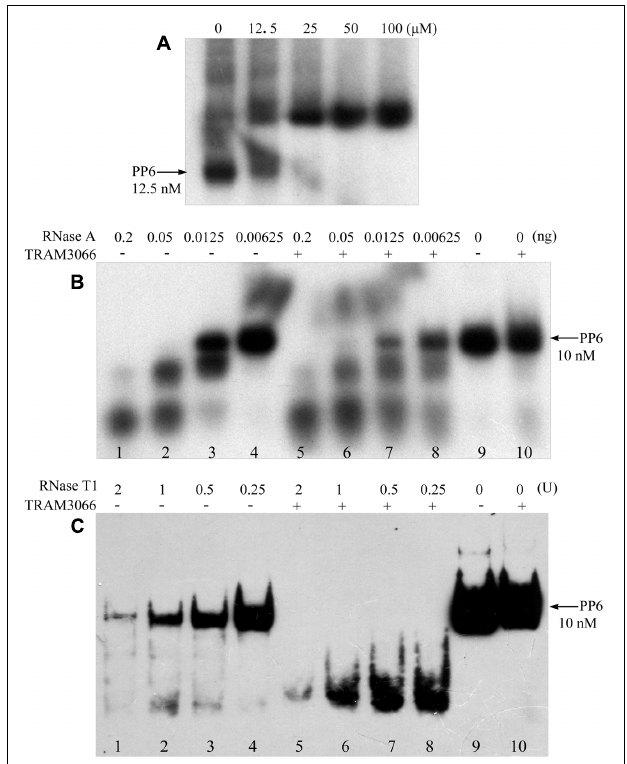
FIGURE 5 | TRAM3066 assisted RNases to hydrolyse structured RNA. The highly structured PP6 RNA was used as the substrate of endonucleases and labeled with [ γ − 32 P] ATP. Using the same procedure as in Figure 4A , rEMSA was performed to detect the concentration of TRAM3066 shown on the top of the gel binding radiolabelled PP6 RNA (A) . Ribonucleolytic assays were performed as described in the Experimental Procedures. PP6 RNA was first mixed with (+) or without (–) 1,000 pmol of TRAM3066 protein, and 0.2, 0.05, 0.0125, and 0.00625 ng (lanes 1–4 and 5–8) of RNase A (B) or 2, 1, 0.5, 0.25 U (lanes 1–8) of RNase T1 (C) was added. After 10 min of reaction at room temperature, the reaction mixture was electrophoresed on a 6% (RNase A assay) or 10% (RNase T1 assay) acrylamide gel at 150 V at room temperature. Arrows point to full-length PP6 RNA. 0, mock without